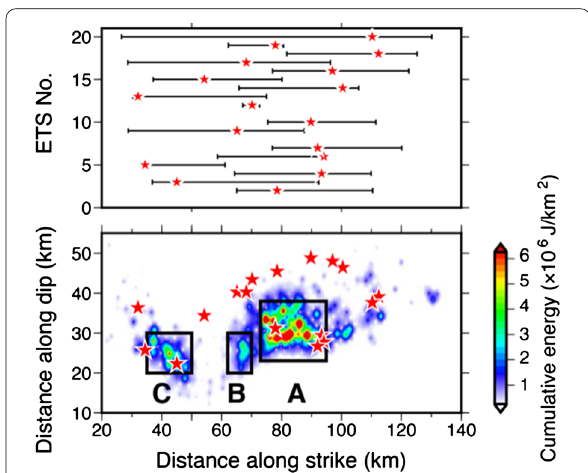
Fig. 6 (upper) Plot showing the rupture extent along the strike direction (black bars) and the start point (red stars) of each ETS event. (bottom) The spatial distribution of cumulative seismic energy release of all ETS events and the start point of each ETS event (red stars). Black rectangles indicate the location of high-energy